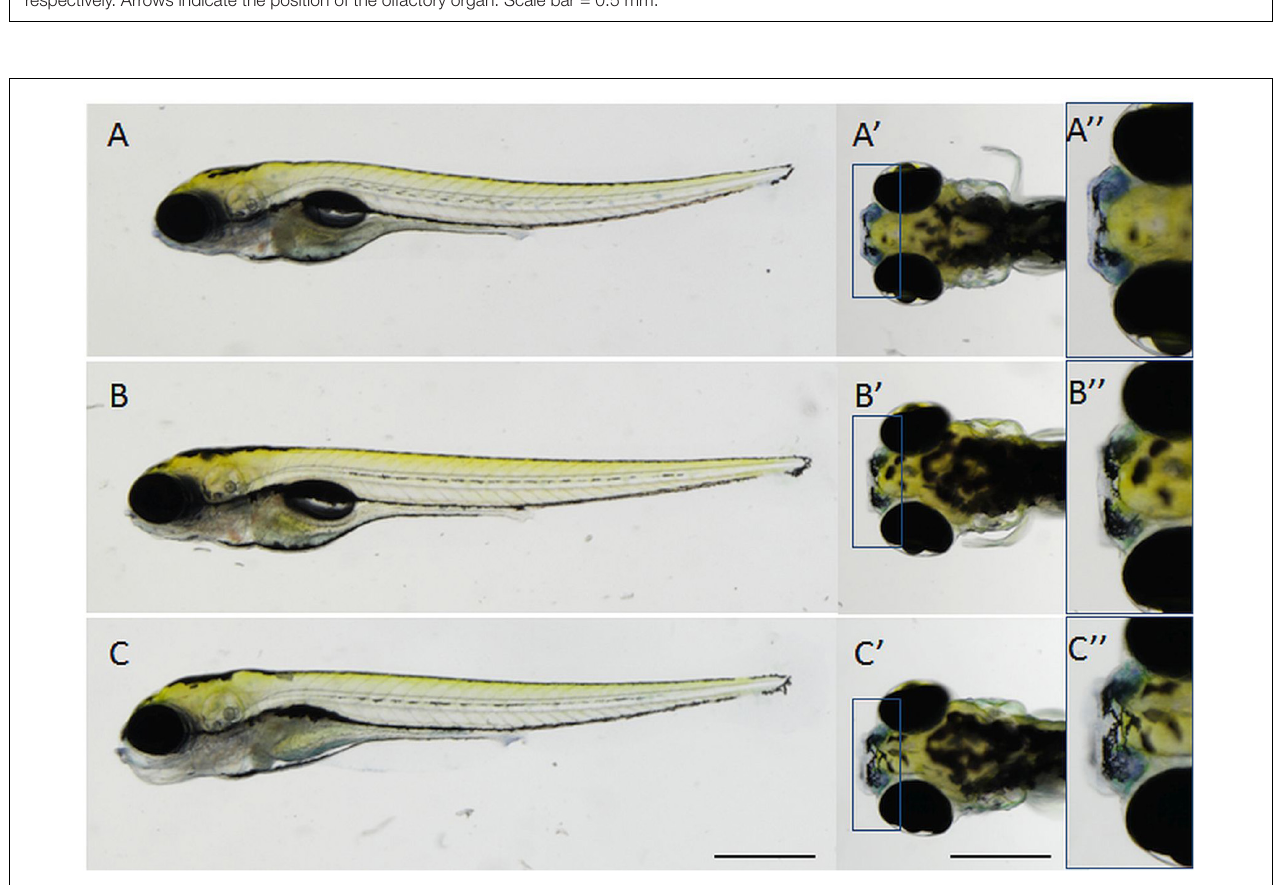
FIGURE 3 | Specificity of Nile blue staining in the olfactory organ in npc2 − / − larvae at 5 dpf. (A–A”) untreated npc2 − / − larvae; (B–B”) treatment with 2 mM 2-hydroxypropyl- β -cyclodextrin (2HP β CD; a drug that is used in clinical trials to treat NPC patients) decreased staining intensity to wildtype levels ( Figures 2A–A ”); and (C–C”) treatment with 8 mM (3 β )-3-(2-[diethylamino]ethoxy)androst-5-en-17-one hydrochloride (U18666A, an inhibitor of cholesterol synthesis that is used to model NPC chemically) increased staining intensity in npc2 − / − larvae. (A–C) lateral view; (A’,A”,B’,B”,C’,C”) , dorsal view; and (A”,B”,C”) enlarged fragments of A’,B’,C’ , respectively. Scale bar = 0.5